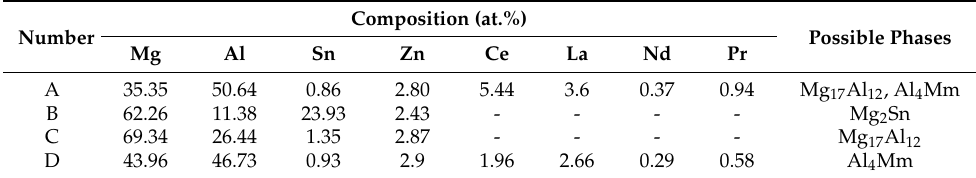
Figure 3. SEM morphology of as-cast ATZE7311 alloy and the EDS results. ( a ) surface morphology, and ( b – i ) are the corresponding distribution of Mg, Al, Sn, Zn, Ce, La, Nd and Pr on ( a ), respectively. ( j , k ) are the point EDS results of the points of A and B in ( a ). Table 2. Elementary compositions of the points showed in Figure 3 and the compositions of the